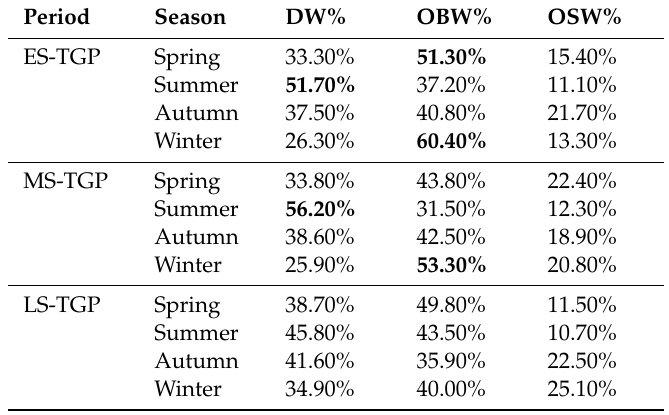
Figure 8. Three end-member mixing model built to distinguish the contribution of potential sources of POC in the research area in the coastal ECS. The graph contains parts of the sample points collected in the ES-TGP in spring; the red squares represent the DW plume (low temperature and low salinity), OSW (high temperature and middle salinity), and OBW (middle temperature and high salinity), respectively. Table 2. Contribution of the DW, OBW, and OSW in four seasons calculated using the three end-member mixing model in di ff erent periods. The bold font indicates that the water mass accounts for > 50% of the data points in the whole water